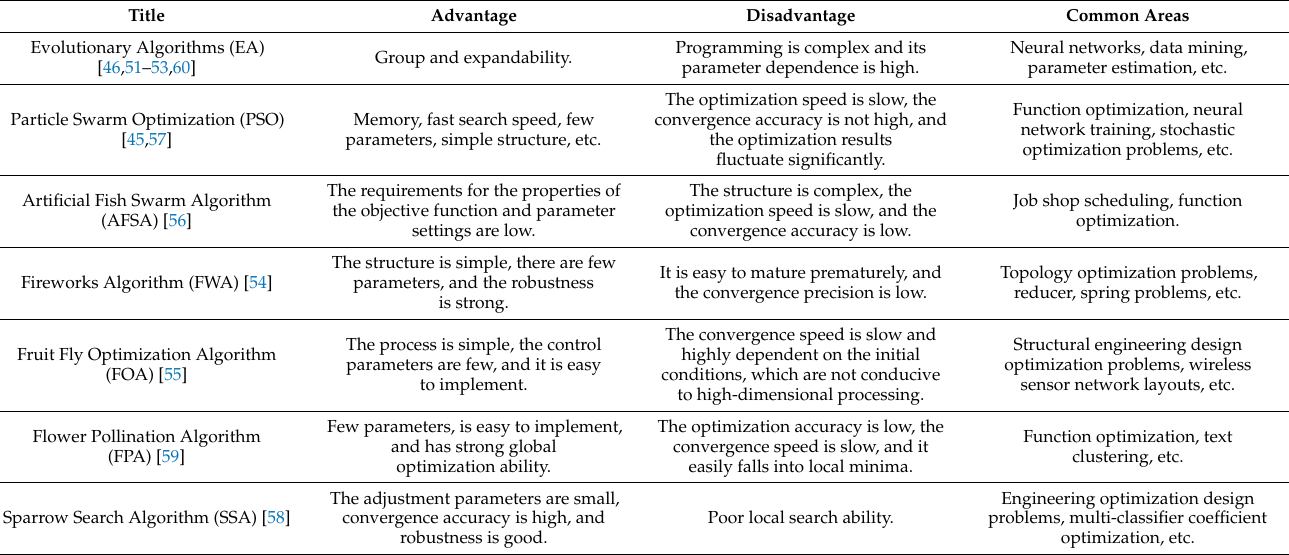
Table 2. Common meta-heuristics.